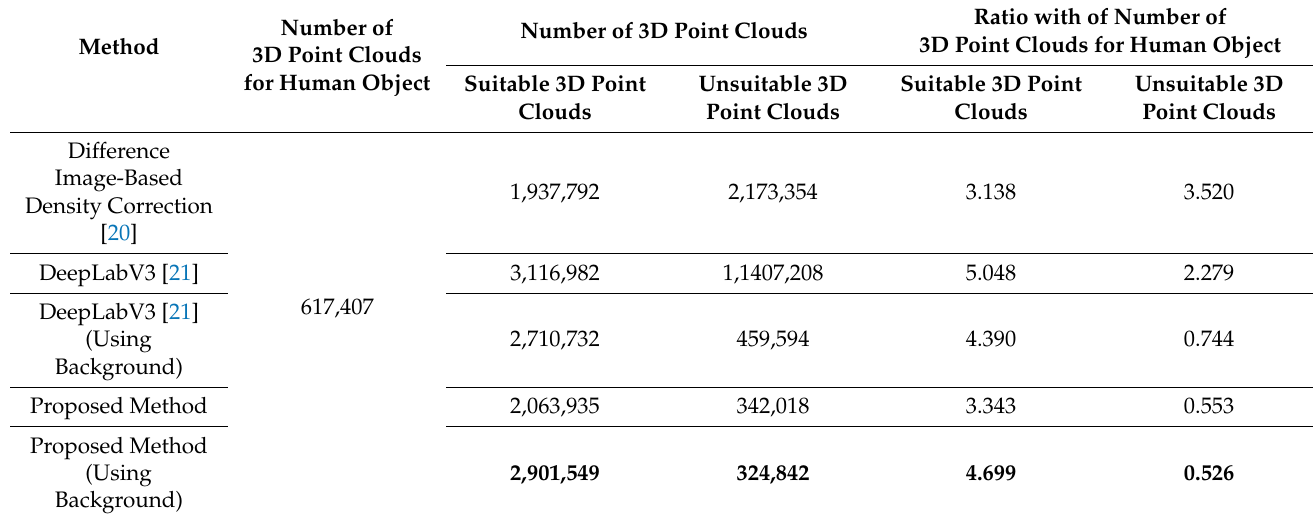
Table 5. Performance evaluation of dense segmentation image.